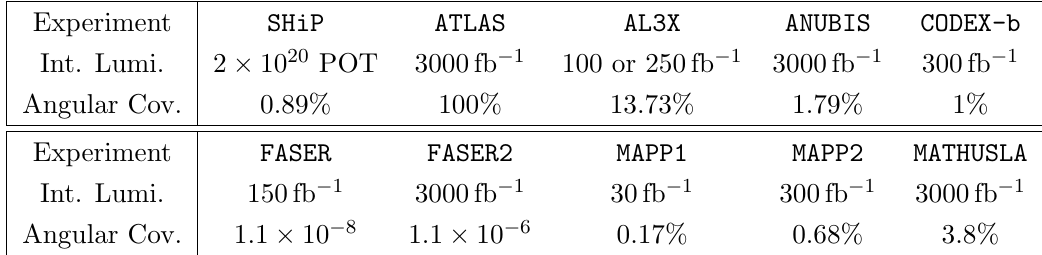
Table 2 . Summary of integrated luminosities for the various experiments. \POT" for SHiP stands for \Protons on Target". We also list the simple geometric coverage for each